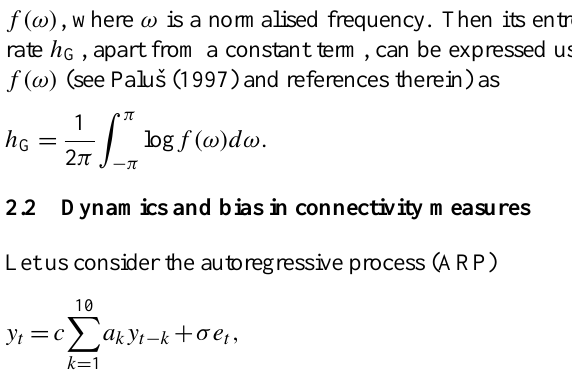
Fig. 2. Histograms of cross-correlations between independent real- isations of the autoregressive process (7) for three different values of the parameter c .